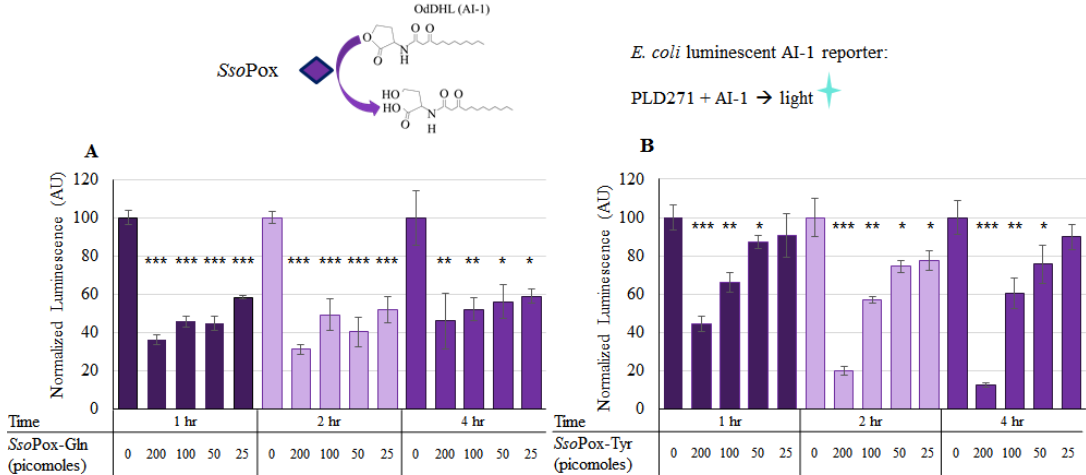
Figure 2. AI-1 quenching with lactonase in solution. In A , known quantities of Sso Pox-Gln were incubated in solution with 225 µM AI-1 (OdDHL) and aliquots of each of three samples were taken at 1, 2 and 4 h. Similarly, in B , known quantities of Sso Pox-Tyr were incubated with 225 µM AI-1 and aliquots of each of three samples were taken at 1, 2 and 4 h. These samples were then diluted 1000 × and measured for relative OdDHL concentration using the JLD271 cell lines; with higher concentrations of OdDHL producing more light/luminescence (See Figure S2). The results are the average of triplicate samples with standard deviations, p -values are calculated using a Student’s t -Test, two-tailed, type 2; * < 0.05, ** < 0.008, *** < 0.0008.